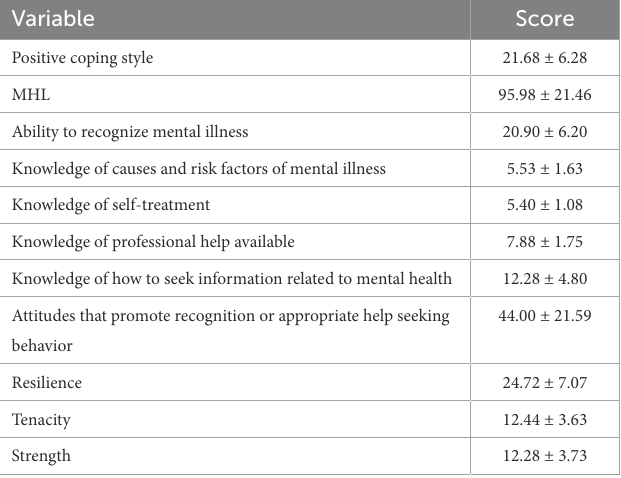
TABLE 2 The scores of positive coping style, MHL and resilience.